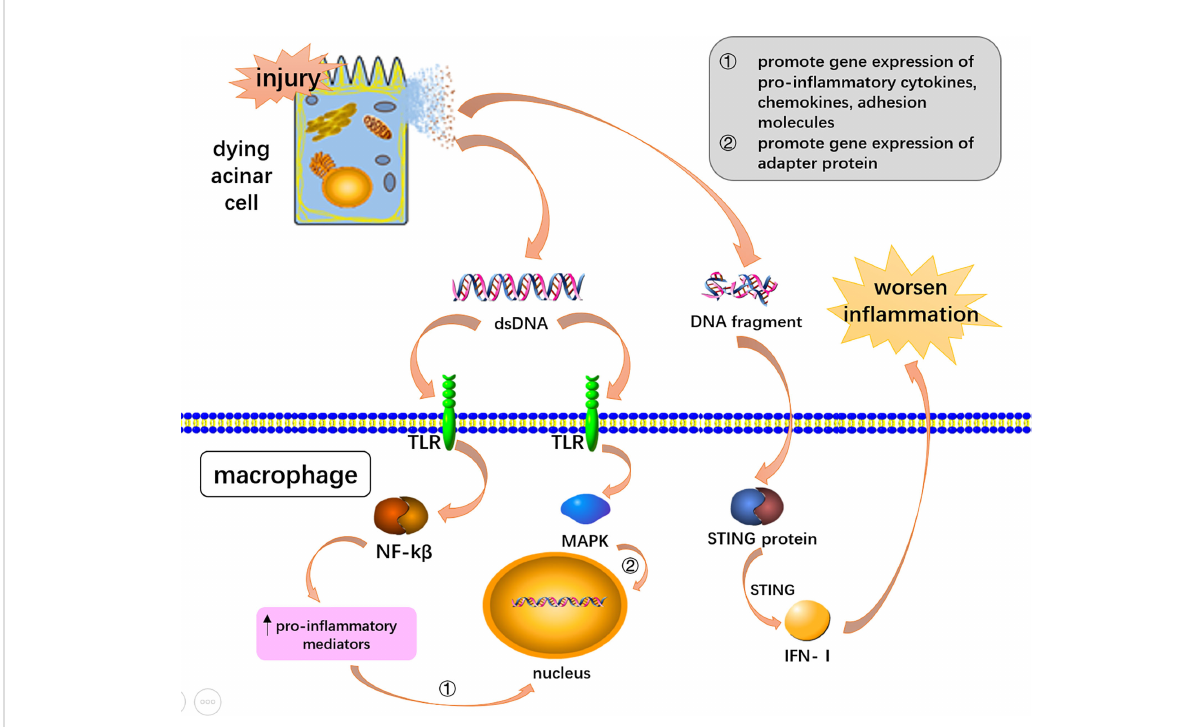
FIGURE 2 DNA mediated in fl ammation via DAMPs receptors and STING signaling. Double-stranded DNA and DNA fragments were released from dying acinar cells. DsDNA activated the NF-KB and MAPK pathway through toll-like receptors to induce AP-associated in fl ammation. DNA fragments worsen AP-associated in fl ammation through STING signaling pathway in